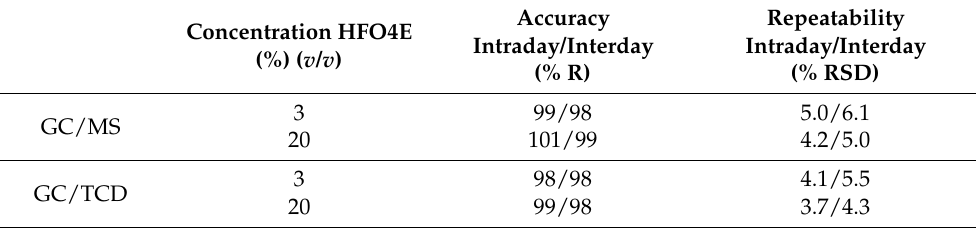
Table 3. Accuracy and repeatability values obtained for HFO4E by GC/MS and GC/TCD. Repeatability Accuracy Concentration HFO4E Intraday/Interday (%) ( v / v ) (% R)